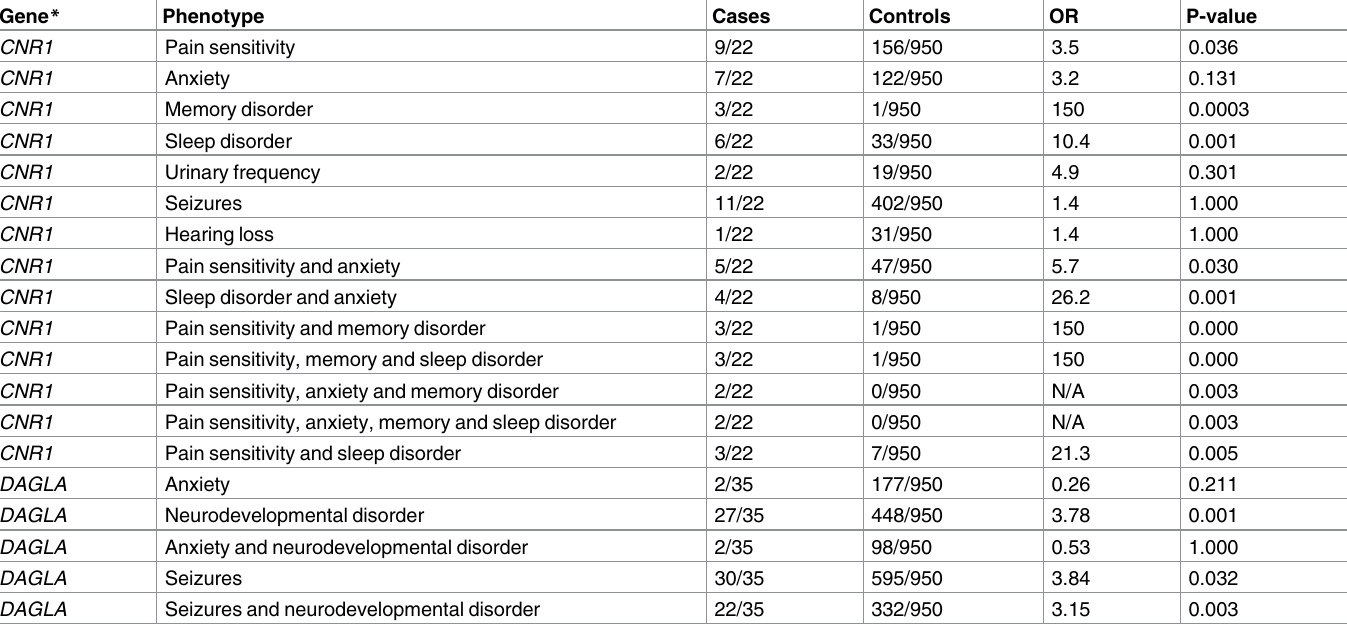
Table 1. Association of mouse knockout phenotypes with rare variants in CNR1 and DAGLA.